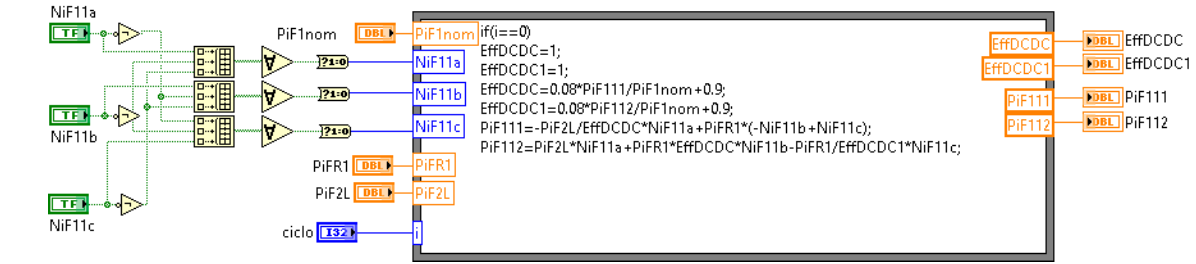
Figure 14. LabVIEW programming for IFCs.